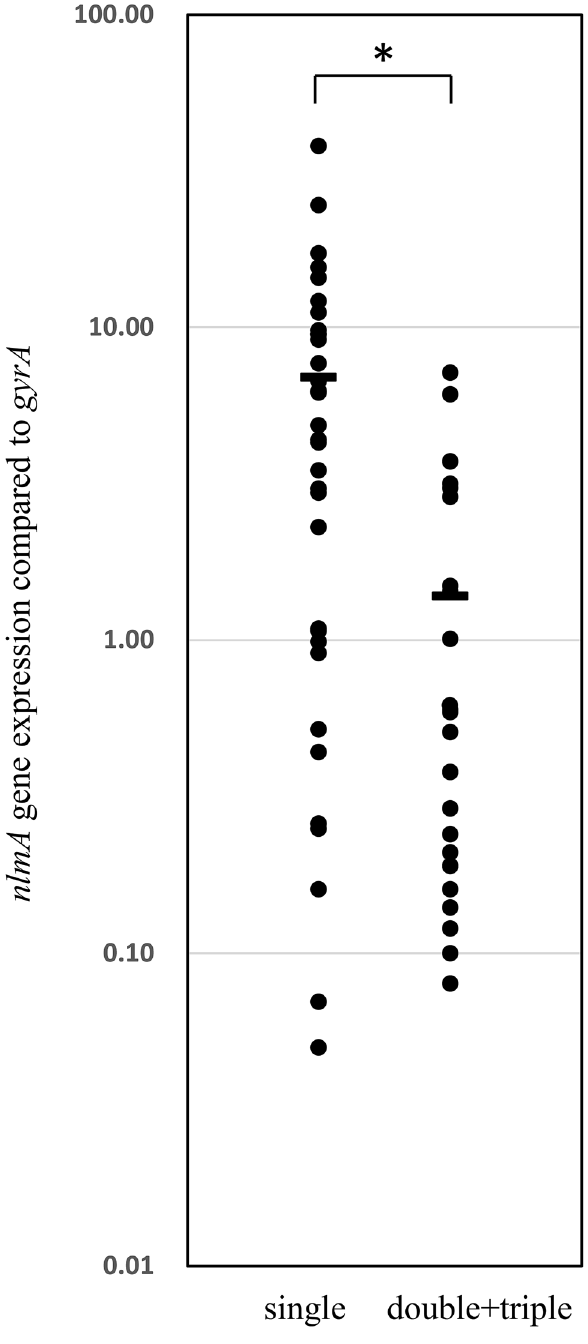
Figure 6. The nlmA gene expression in all mutacin IV-positive strains. NlmA gene expression in all mutacin IV-positive strains was analysed by the method described in the Materials and methods section. The horizontal bar indicates the average expression. * p < 0.05, as determined by t